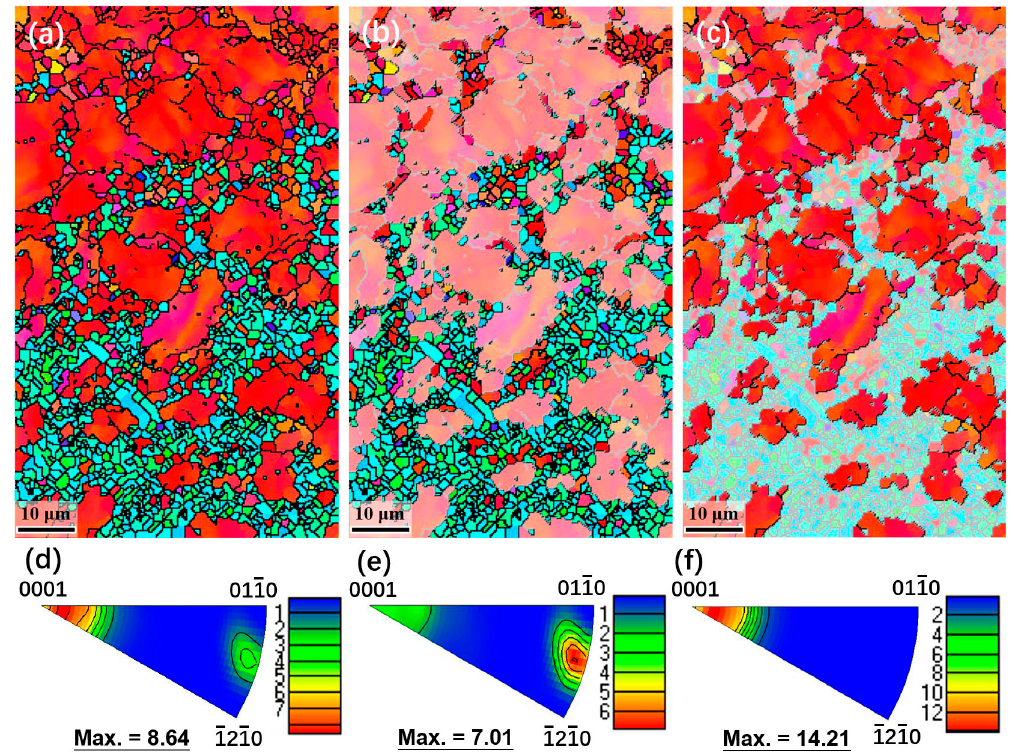
Figure 7. ( a,b,c ) Inverse pole figure maps and ( d,e,f ) inverse pole figures of the E-CRed BX11 alloy; ( a,d ) overall, ( b,e ) un-DRXed, and ( e,f ) DRXed regions. ( a,d ) overall, ( b,e ) un-DRXed, and ( e,f ) DRXed